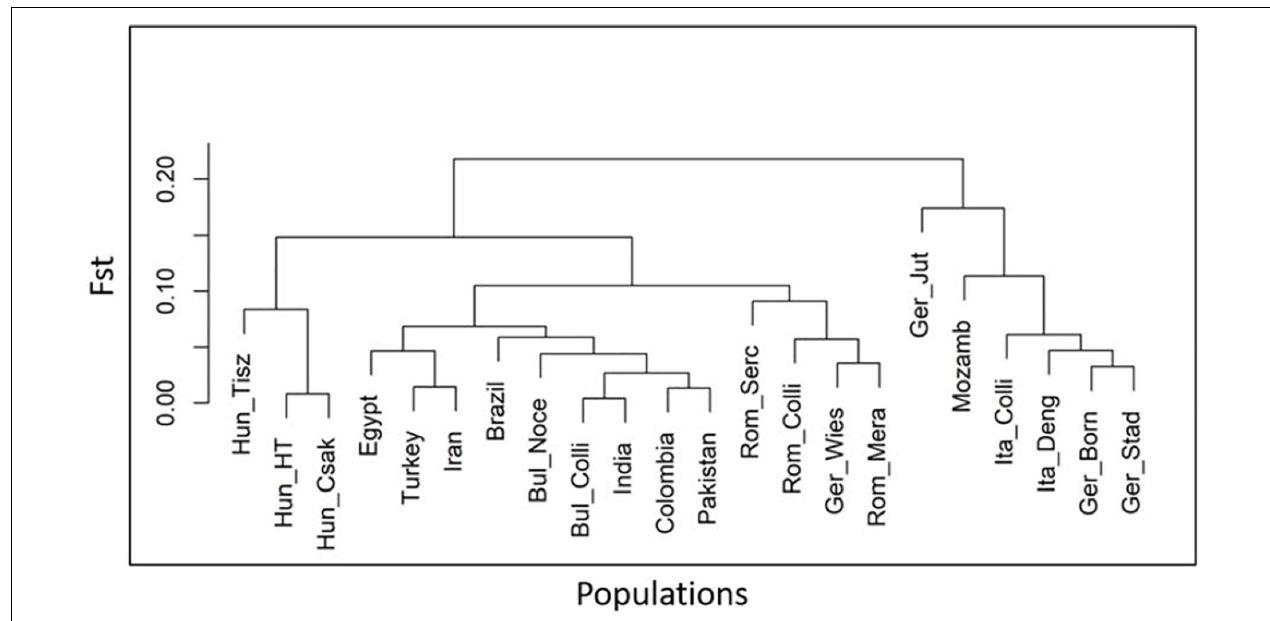
FIGURE 5 | Phylogenetic tree indicating the genetic distance of 22 buffalo populations, analyzed and published in part (Colli et al., 2018a; Deng et al., 2019a), with worldwide distributions based on the fixation index (FST) matrix obtained from 36,014 SNPs in 477 individuals using Arlequine software. Abbreviations and sample numbers are specified in Figure 3